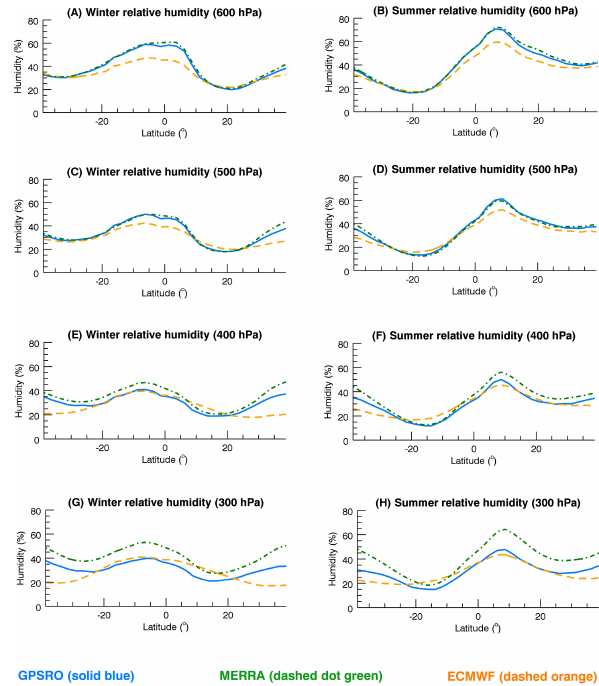
Figure 3. Same as Fig. 2 but for the middle-to-upper